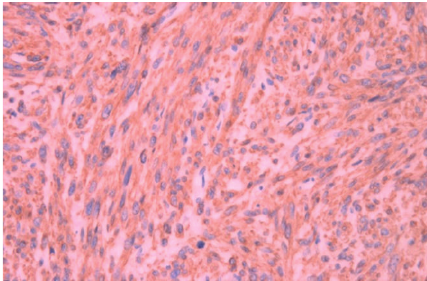
Figure 1: Interlacing fascicles of spindle cells.